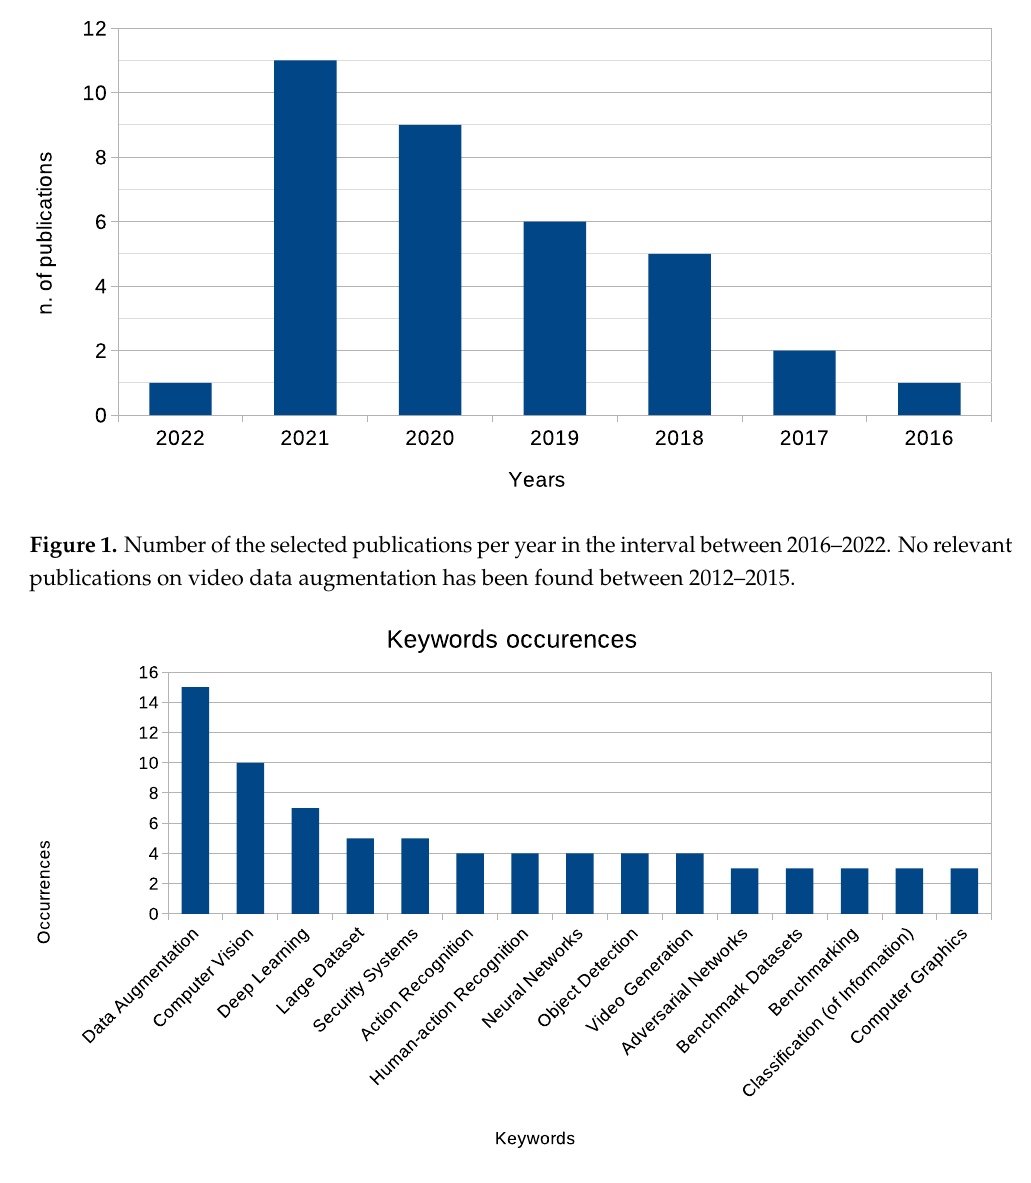
Figure 2. Number of occurrences of the 15 most frequently occurring keywords in the selected